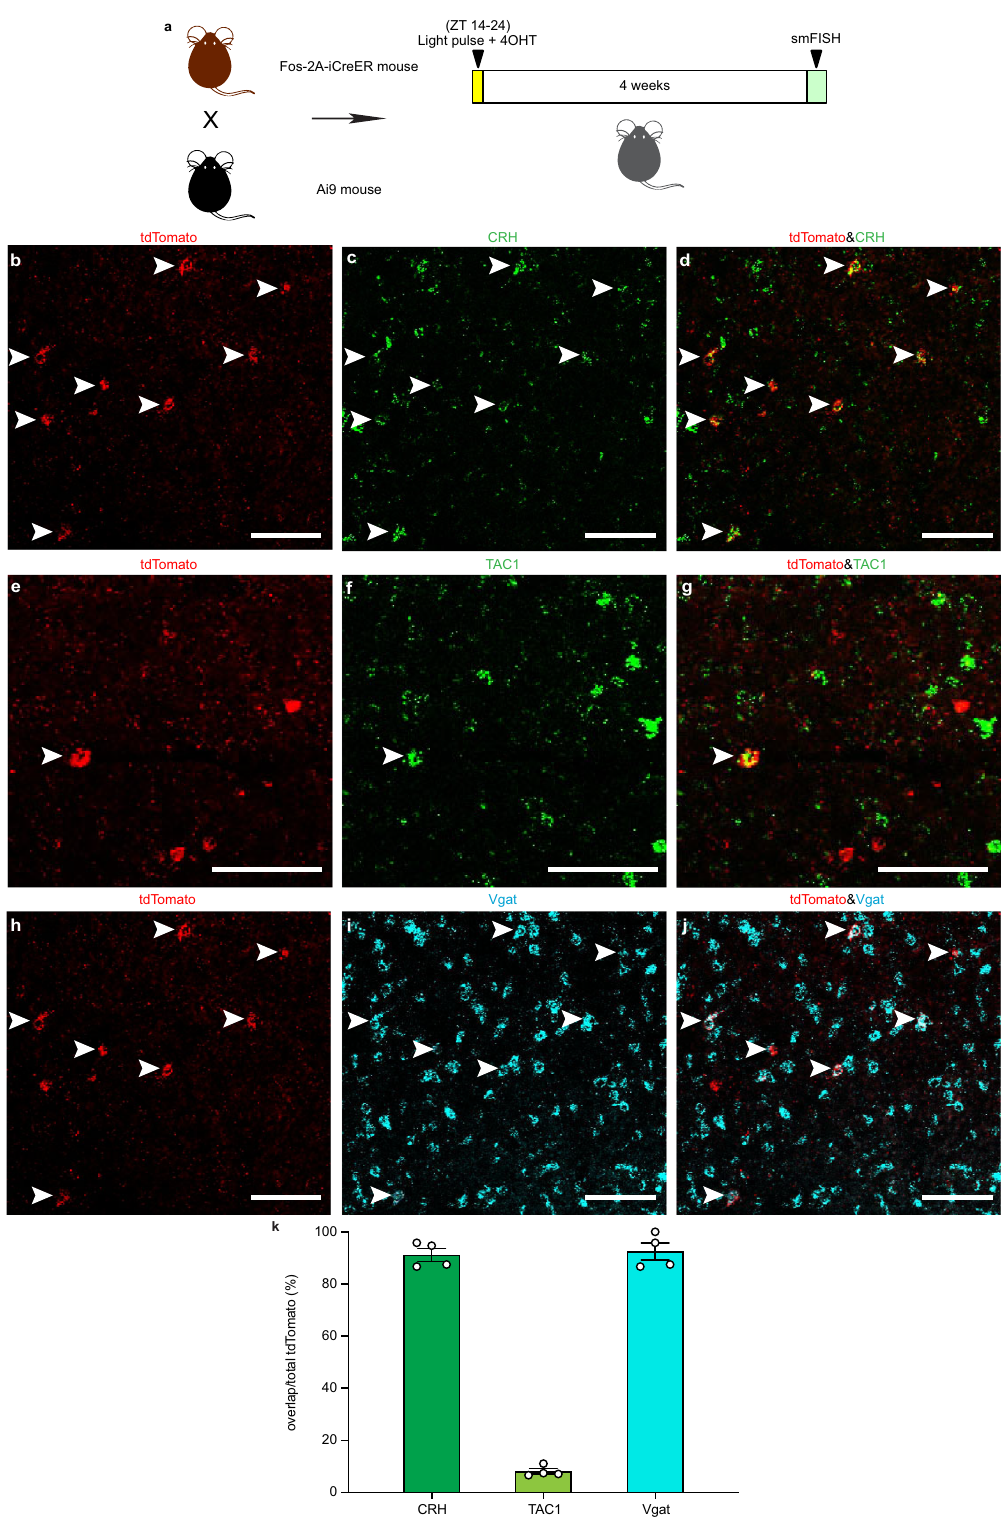
Fig. 4 Characterization of light-responsive neurons in the POA. a Schematic showing Fos-2A-iCreER and CAG-FLEX-tdTomato (Ai9) mice that received light exposure, 4-Hydroxytamoxifen (4-OHT) injection and single-molecule fl uorescence in situ hybridization (smFISH). b – d Distributions of tdTomato positive neurons ( b ), CRH positive neurons ( c ), and colocalization ( d ) in the POA ( n = 4 animals; scale bar, 100 μ m). e – g Distributions of tdTomato positive neurons ( e ), TAC1 positive neurons ( f ), and colocalization ( g ) in the POA ( n = 4 animals; scale bar, 100 μ m). h – j Distributions of tdTomato positive neurons ( h ), Vgat positive neurons ( i ), and colocalization ( j ) in the POA ( n = 4 animals; scale bar, 100 μ m). Arrowheads indicate colabeled neurons. k Percentages of CRH, TAC1, and Vgat positive cells in tdTomato positive neurons ( n = 4 animals). All error bars denote SEM. ZT, zeitgeber time; CRH, corticotropin- releasing hormone, TAC1, tachykinin-1; Vgat, vesicular GABA